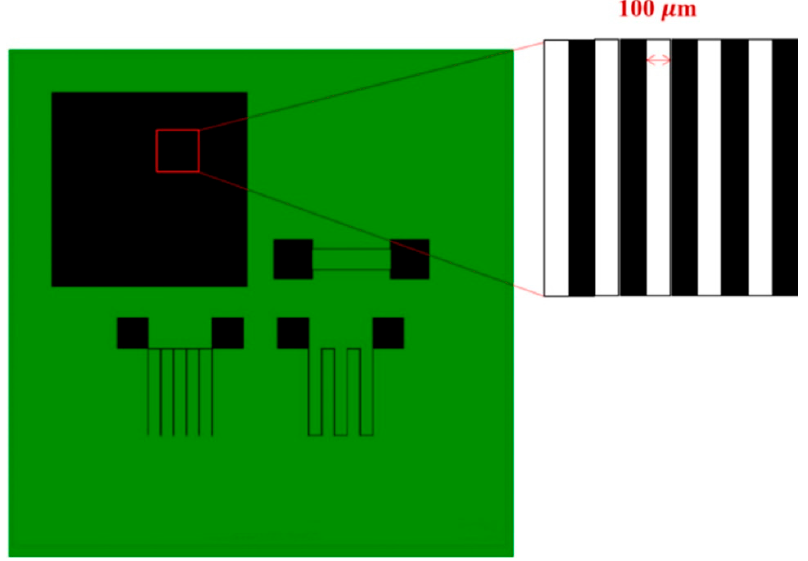
Figure 1. Pattern mask design: line pattern and cube pattern.